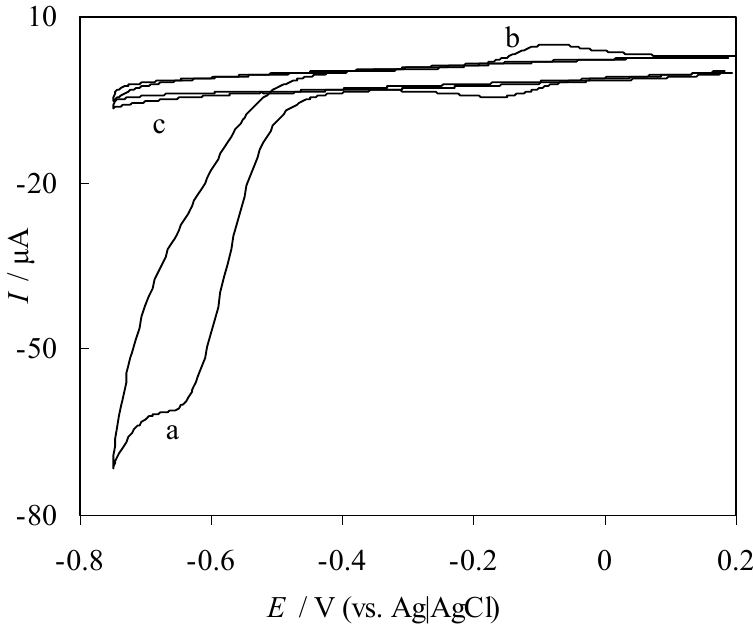
Figure 3. Cyclic voltammograms of FePyDP film modified PG electrode in 50 mM PBS (pH 7.4) (a) with 82.3 µ M NO and (b) with 100 µ M NO 2- . Curve (c) is obtained in pure PBS at DNA-PADDA film with 82.3 µ M NO. Scan rate, 200 mV s -1